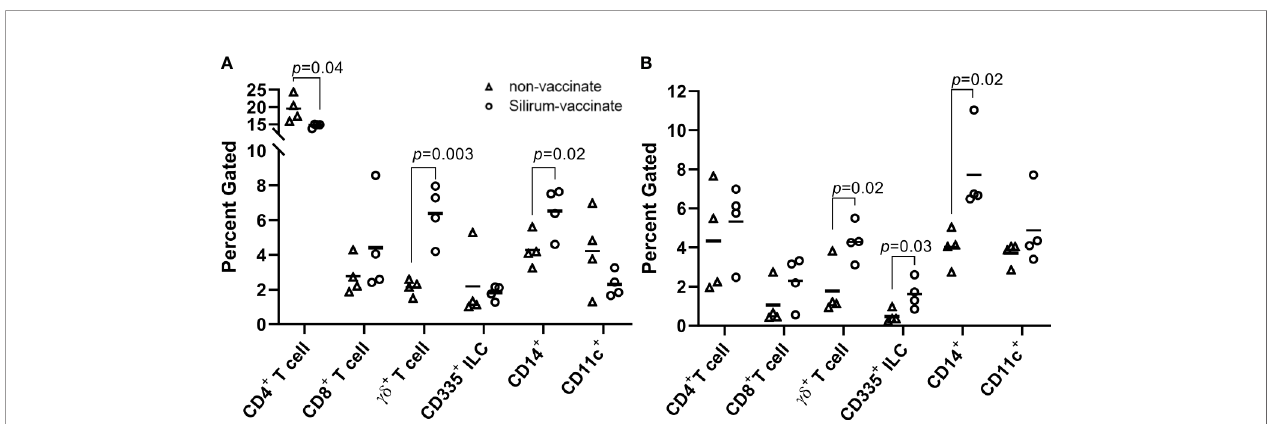
FIGURE 5 | Silirum vaccination alters the frequency of mucosal leukocyte populations following enteric Mycobacterium avium ssp. paratuberculosis (MAP) infection. Frequency of T cells (CD4 + , CD8 + , gd + ), ILCs (CD335 + ), and myeloid cells (CD14 + , CD11c + ) in PP cells isolated from (A) discrete PP (DPP) and (B) continuous band of PP (CPP) of Silirum vaccinates (n=4) and non-vaccinates (n=4) at 28 days post-infection. Each data point represents the percent gated (frequency of cells in 10,000 events) for one calf. Horizontal line represents the mean value for each group; p values were determined using a Student ’ s t